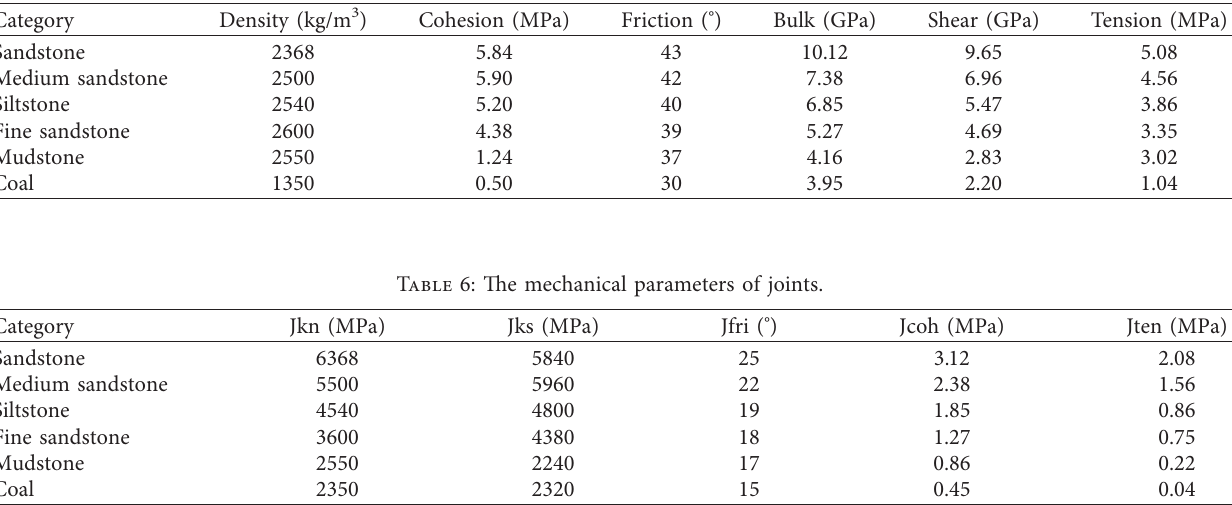
Table 5: Parameters for different rock masses tested.